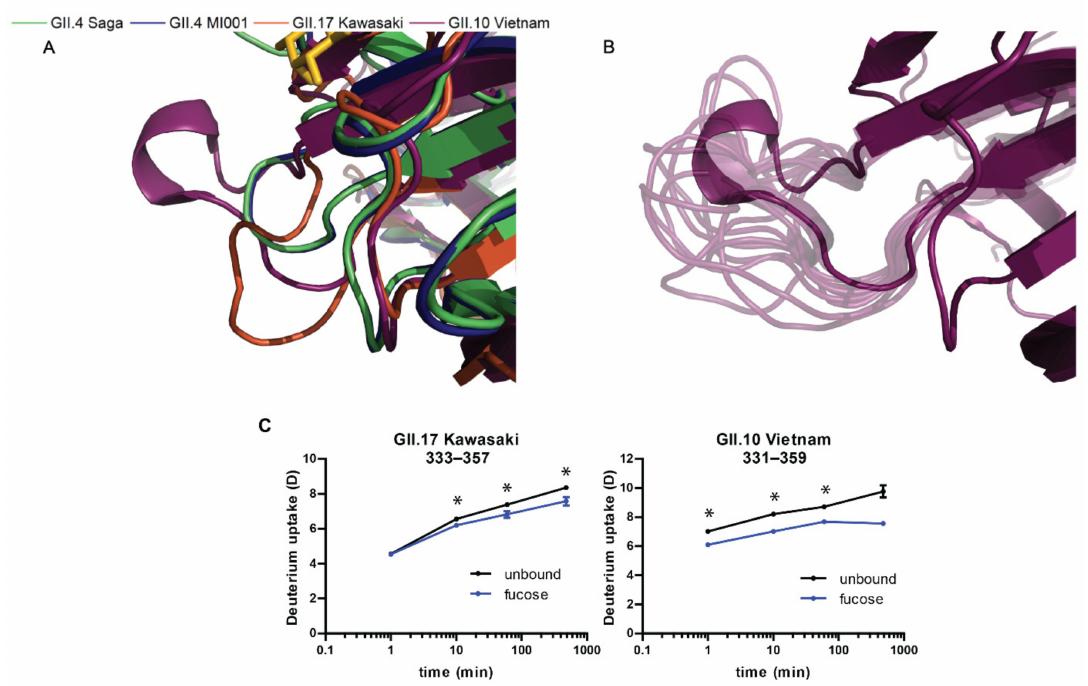
Figure 6. Structural rearrangement of the glycan binding site in absence of fucose. ( A ) Zoomed in image of the overlaid P domain structures around residue 350, complexed with fucose. The presence of fucose stabilizes a small helix, forming an ordered pocket in the GII.10 Vietnam strain (purple). ( B ) Absence of fucose results in a high flexibility of the GII.10 Vietnam pocket and a loss of the short helix, as shown in the snapshots of different conformations throughout the simulation (light purple). These snapshots were taken from every 10th frame of a single trajectory. ( C ) Deuterium uptake plots show significant protection (*) around residue 350 in presence of fucose, with largest deuteration differences in GII.10 Vietnam. Error bars represent the standard